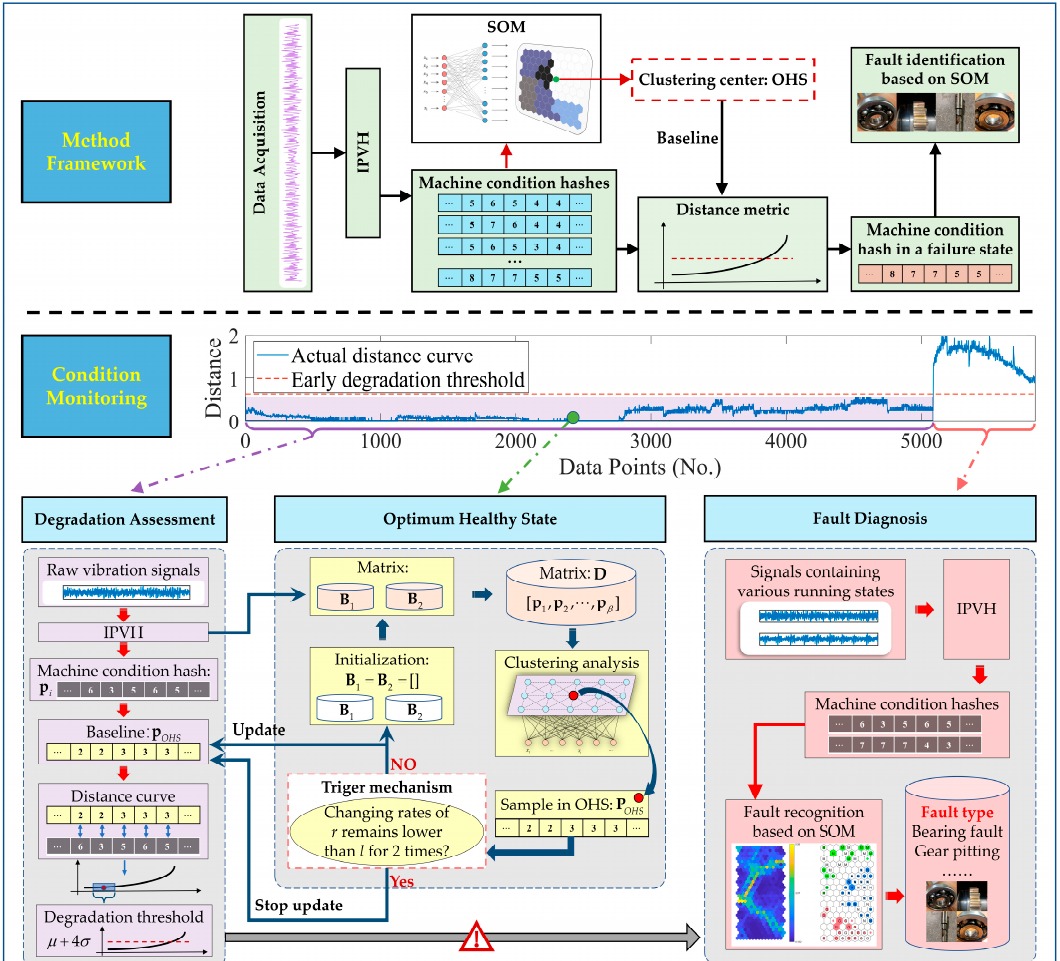
Figure 2. Flowchart of the proposed condition monitoring framework.